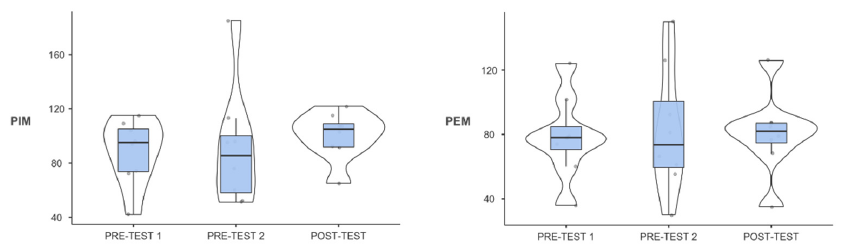
Figure 1. Box plots of PIM ( left ) and PEM ( right ) scores at the three measurement points. PIM = maximal inspiratory pressure; PEM = maximal expiratory pressure. *The dots show the position of the different subjects on the graph.